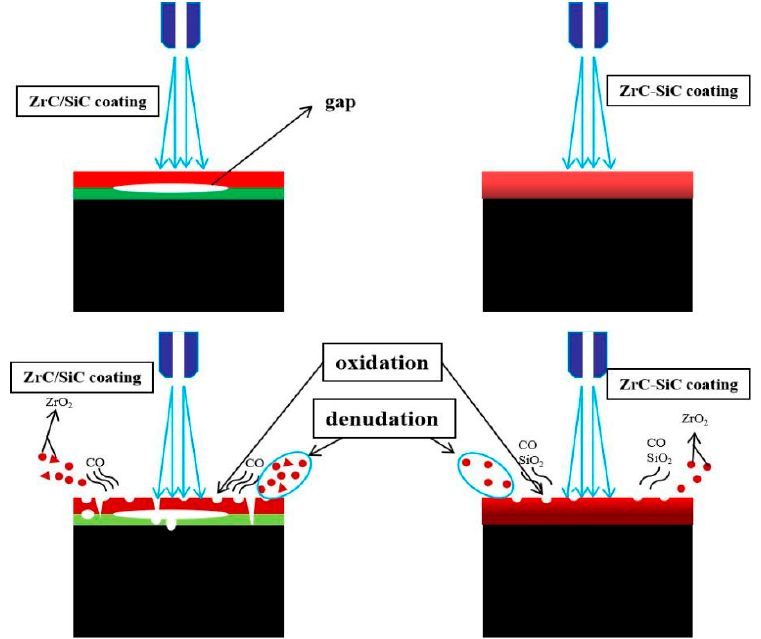
Figure 12. The diagram of ZrC/SiC and ZrC-SiC coatings during ablation process.